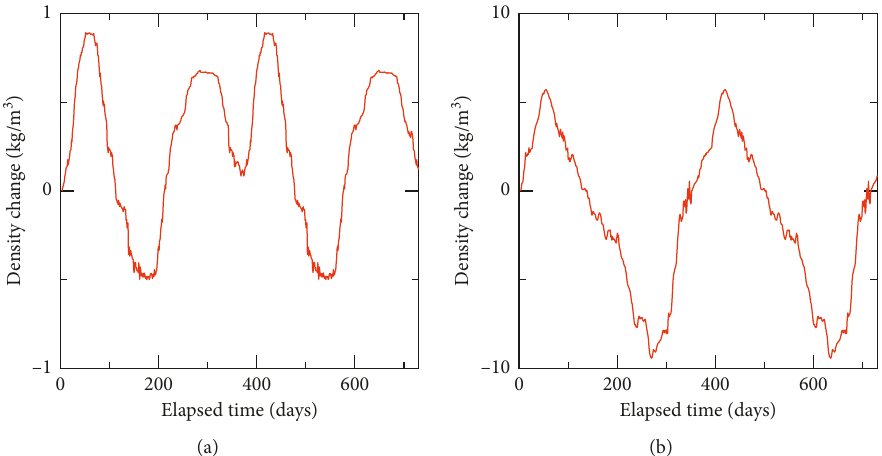
Figure 17: Density change for FEM simulation converted from smoothed humidity data. Time is from February 15. (a) Underground conditions. (b) Outside